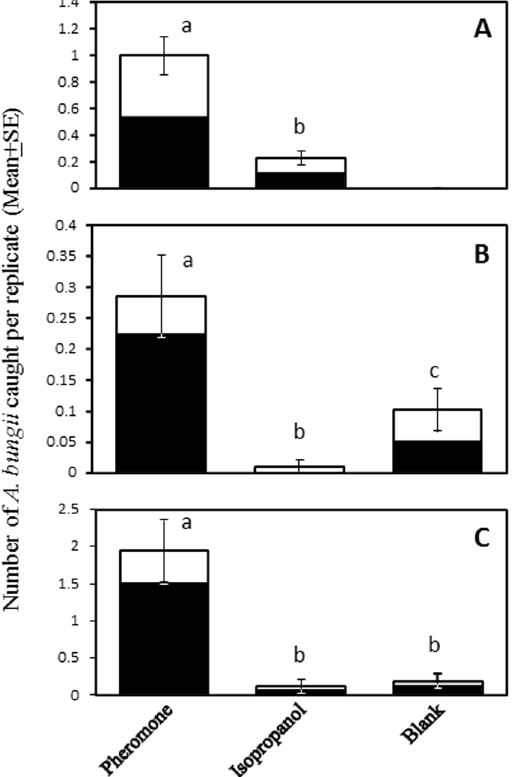
Figure 5. Numbers of A. bungii captured in traps baited with ( A ) the putative pheromone [( E )-2- cis -6,7- epoxynonenal, 25 mg] and control (isopropanol) in the first bioassay in China; and ( B ) and (C ) ( E )-2- cis -6,7- epoxynonenal, isopropanol, and unbaited traps in the second bioassay in China and the bioassay in Japan, respectively. White bars represent males and black bars represent females. Bars with the same letter are not significantly different (P > 0.05). Each pair of treatments was compared using Poisson regression analysis followed by pairwise